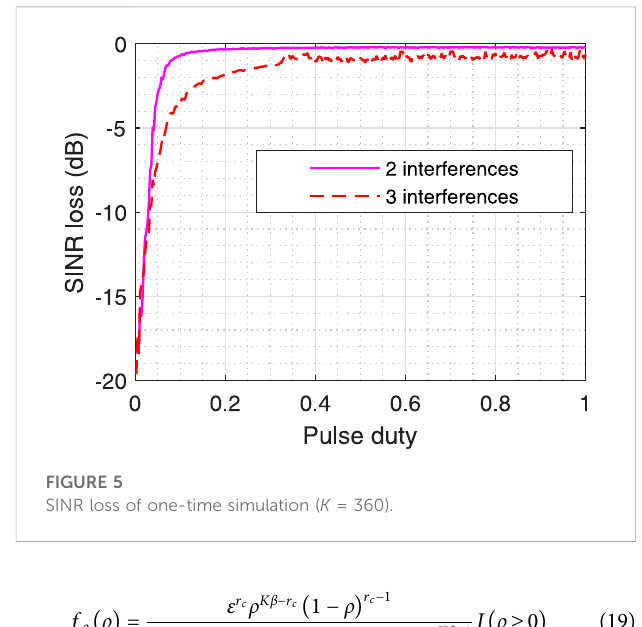
FIGURE 4 Average SINR loss of Monte Carlo simulations ( K = 360).